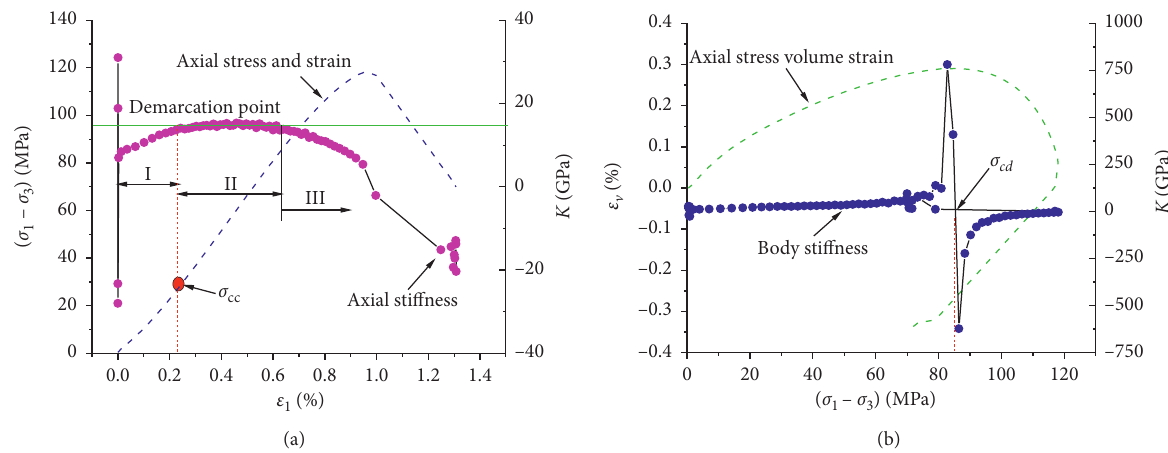
Figure 6: Calculation method of characteristic stress. (a) Closed stress calculation curve; (b) damaged stress calculation curve.